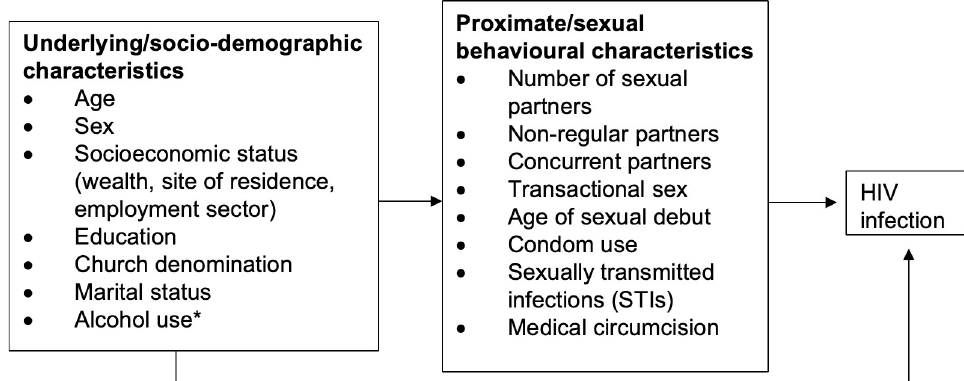
Fig 1. Proximate and underlying determinants of HIV infection. Socio-demographic characteristics influence HIV infection status via proximate factors (sexual risk behaviours) which in turn modify the biological risk of HIV infection. For instance, the number of sexual partners, non-regular partners, concurrent partners, transactional sex and age of sexual debut influence the probability of exposure of susceptible to infected individuals, while condom use, concomitant STIs and medical circumcision affect the efficiency of transmission per sexual contact. � Alcohol use is considered as a background factor as it is believed that its impact on HIV infection is mediated by sexual risk behaviours.